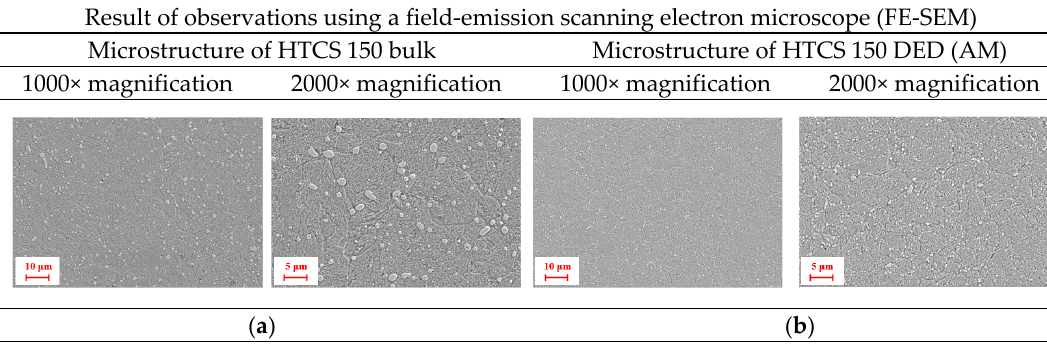
Figure 6. Analysis results of the microstructures of the HTCS-150 material applied with heat-treatment process ( a ) microstructure of the HTCS-150 bulk material ( b ) microstructure of the HTCS-150 AM material. Table 6. Thermal conductivity and surface hardness of HTCS-150 with heat treatment.